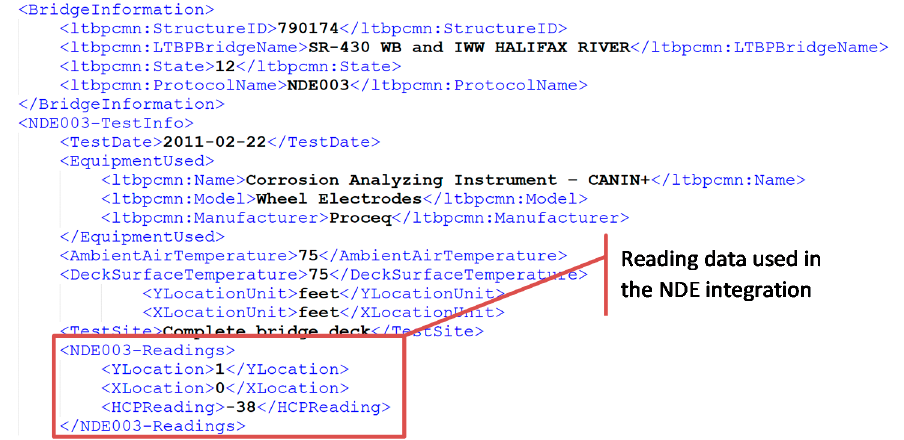
Figure 5. Example NDE data collected from a bridge deck (electrical resistivity).